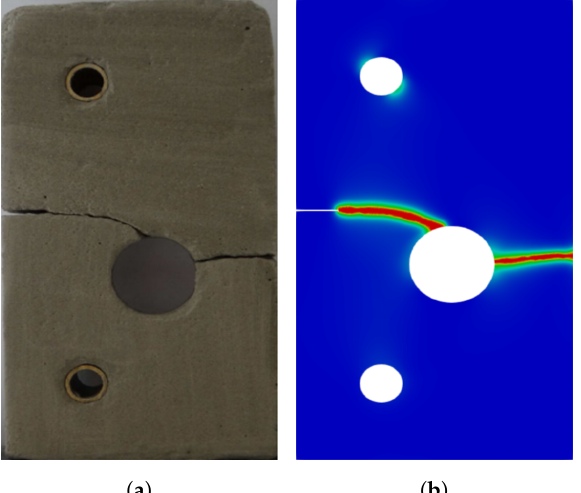
Figure 29. NPwH comparison of crack topologies depicting experiments from ( a ) [243] vs. ( b ) phase field